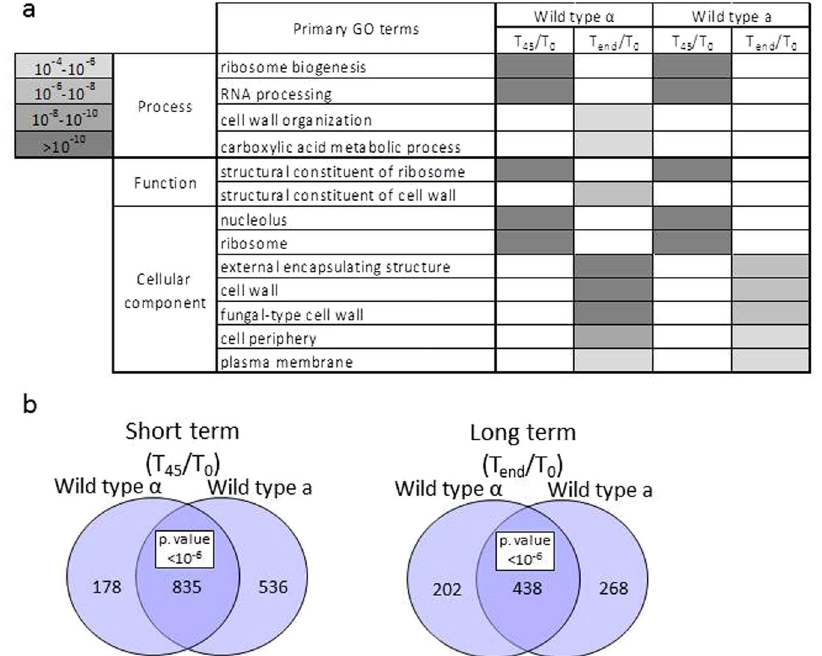
Figure 5. Transcriptomic changes imposed by CaCl 2 on wild-type strains. ( a ) Heatmap of SGD GO enrichment analysis of significantly affected genes in T45/T0 and Tend/T0 in the two wild-type strains. The grey shades indicate levels of enrichment score of each GO term. Only primary GO terms with p value < 10e − 4 and FDR ≤ 0.01 are presented. Full results are presented in Supplementary Table S3. ( b ) Venn diagram of significantly affected genes (changed by more than two fold relative to T0, adjusted p value 0.05) in WT ‘a’ (yA635) and WT α (yA995). The hypergeometric test was used to calculate significance for the merged